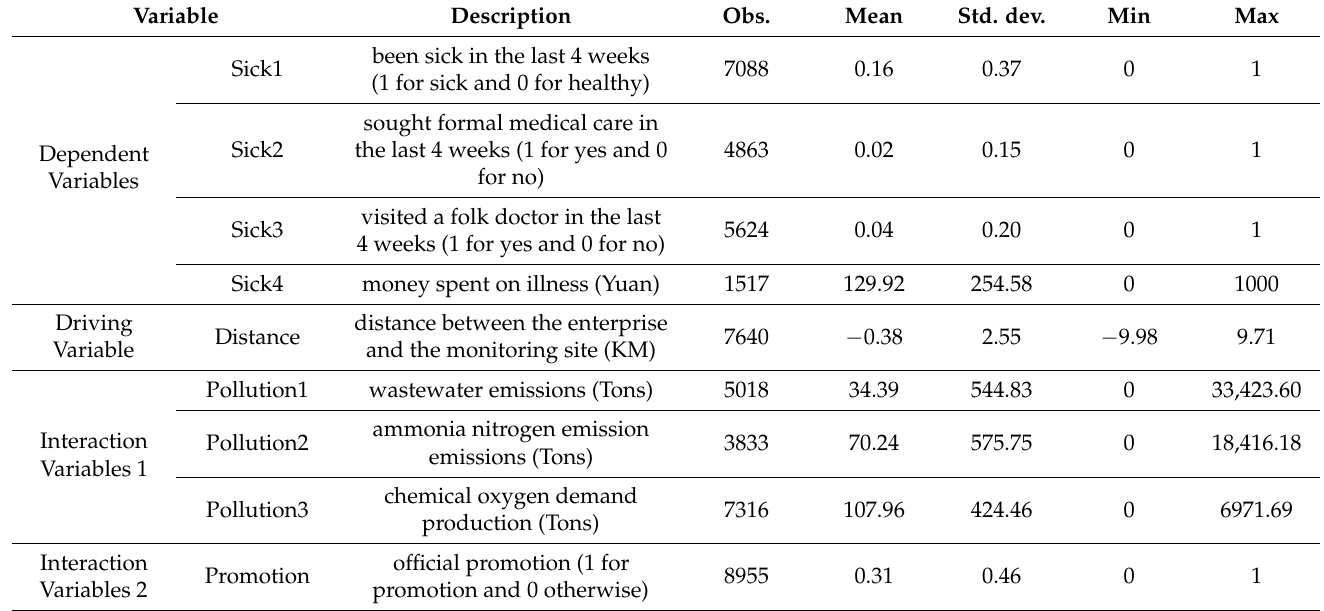
Table 1. Descriptive statistical results for the main